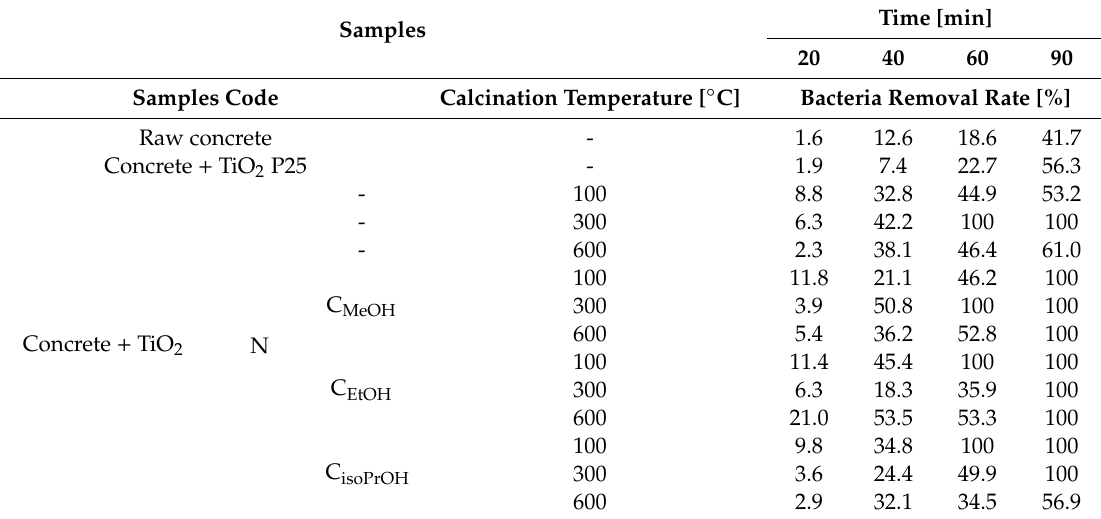
Table 3. The reduction [%] of initial bacteria cells number under artificial solar light. Samples